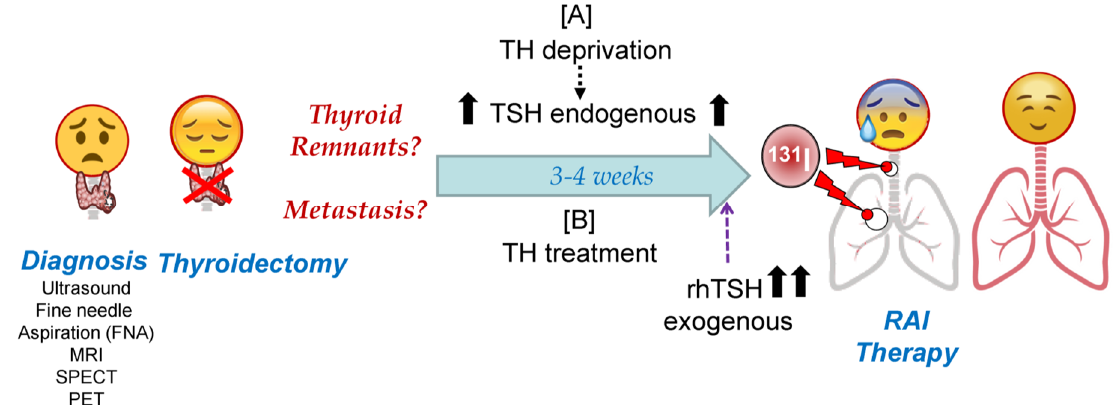
Figure 3. Schematic representation of Radioactive Iodide (RAI) therapy in patients with differentiated thyroid cancer (DTC). After tumor diagnosis, the final goal of both pre-RAI treatments is to achieve maximum radioiodine accumulation in tumor cells, with maximum residence time during 131 I therapy. Molecularly speaking, this translates to the maximum accumulation of radioiodine through NIS and the maximum iodine organification in TG or other molecules that are able to oxidize iodide. Abbreviations: TH: Thyroid Hormones; TG: thyroglobulin; TSH: Thyroid Stimulating Hormone; rhTSH: recombinant human TSH; MRI: Magnetic resonance imaging; SPECT: Single-photon emission computed tomography; PET: Positron emission tomography.